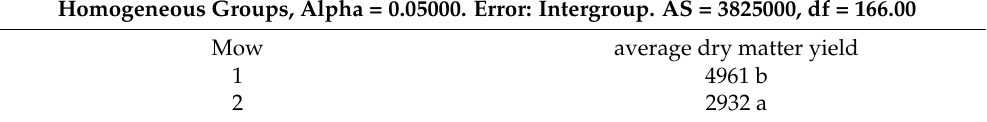
Table 14. LSD test: average dry matter content (kg ha − 1 ) in perennial crops (RCG, Sz-1, M × G) during every mow.